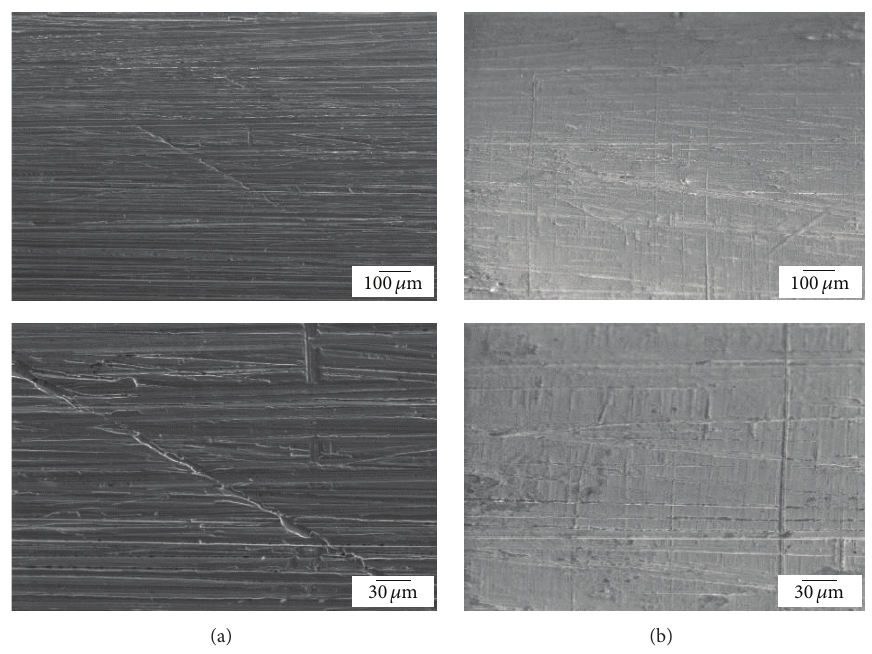
Figure 18: SEM images of die radius—ground surface: (a) before and (b) after hot stamping